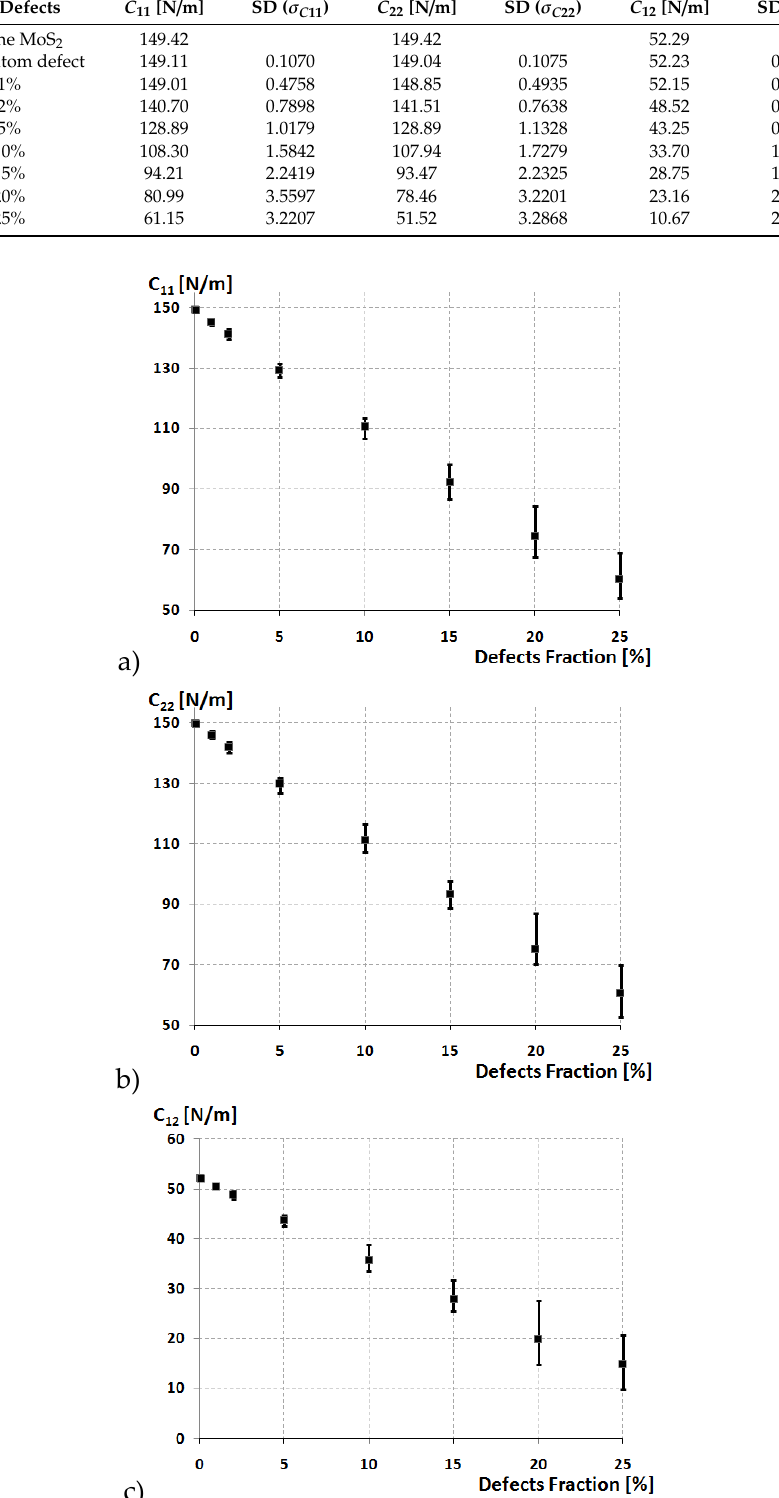
The elastic constants of monolayer MoS 2 nanosheet vs. the defect percentage are presented in